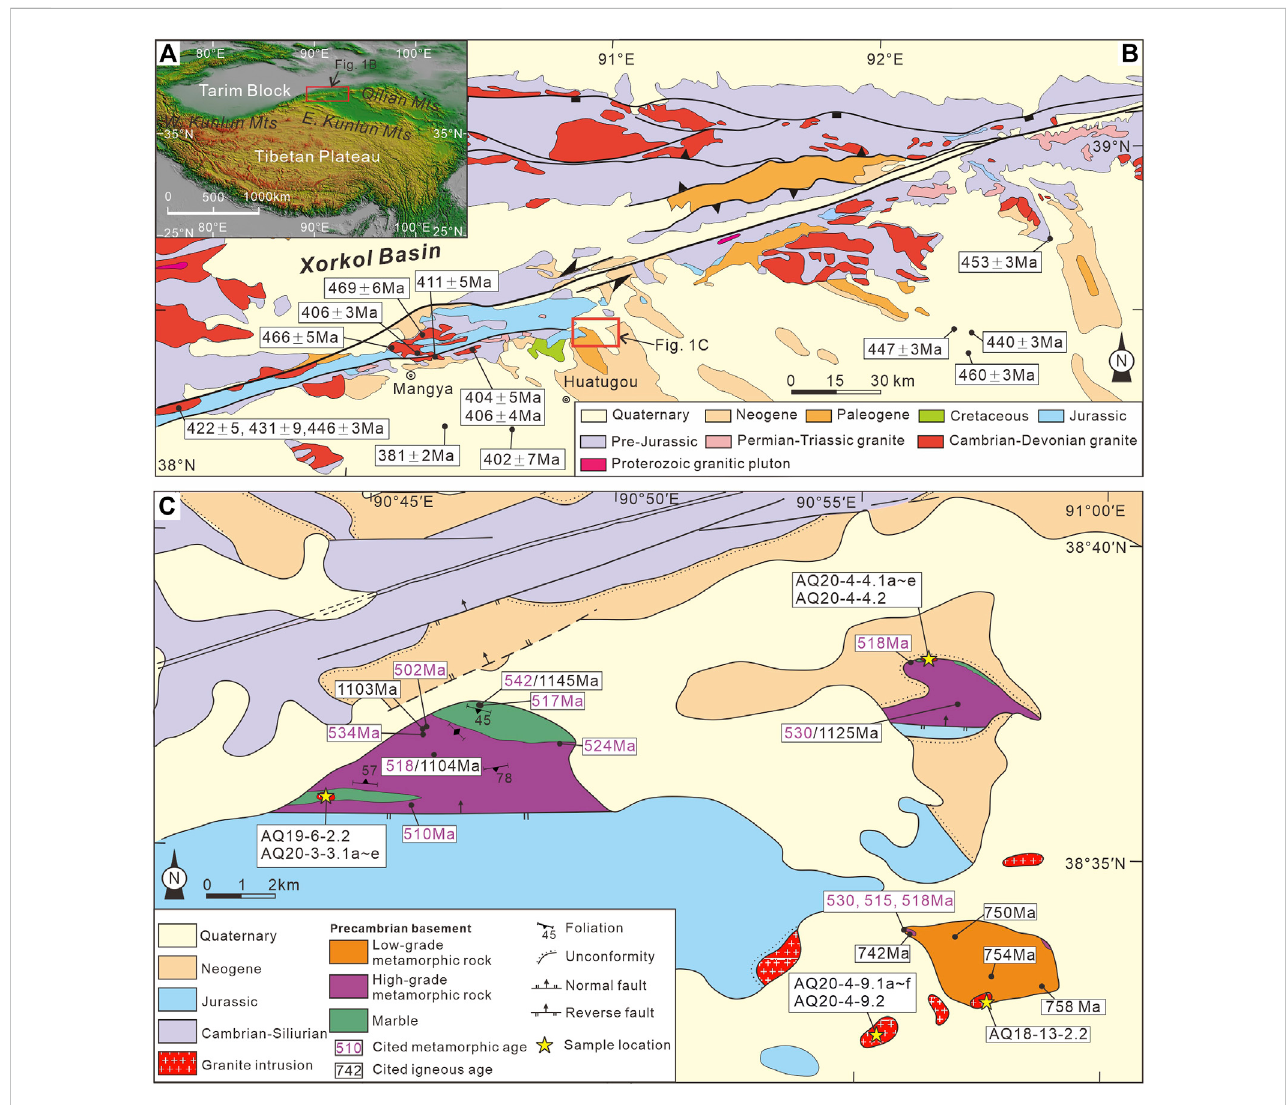
FIGURE 1 (A) LocationoftheQaidam basin. (B) Simpli fi edwestern Qaidam geological map(after Chengetal., 2017).Zircon U-Pb dataofearlyPaleozoic granitoids are cited from Cheng et al. (2017), Wang C. et al., (2014a), and Wu C. L. et al. (2014b). (C) Simpli fi ed geological map of the study region showing primary lithologies and sample locations. Magmatic and metamorphic zircon U-Pb data are cited from Teng et al. (2020,